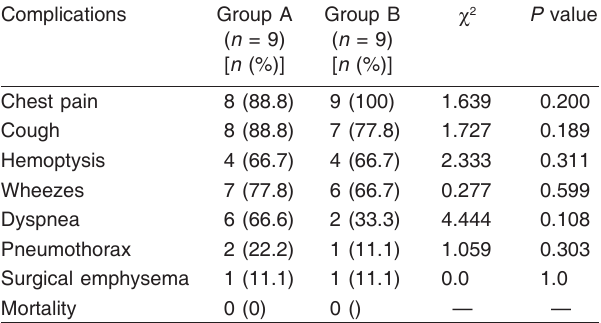
Table 4 Immediate complications after injection of the ablative agents